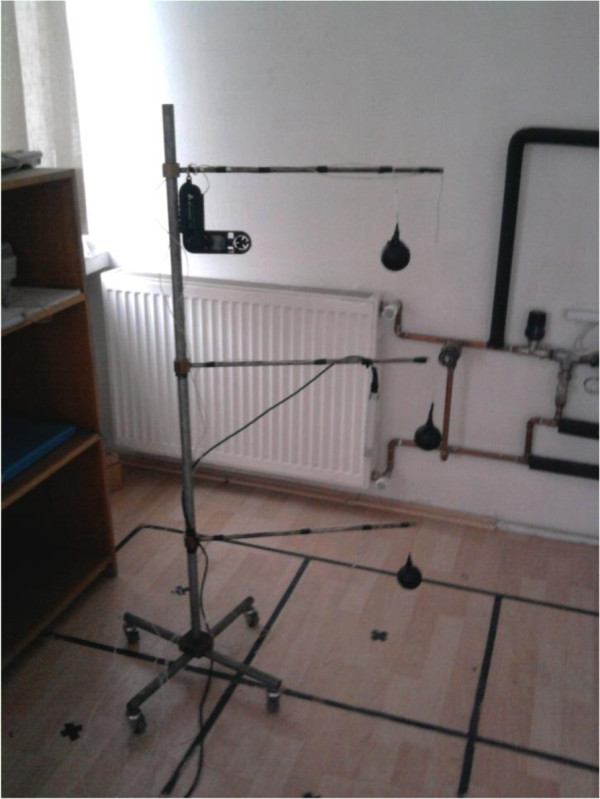
Measuring setup.